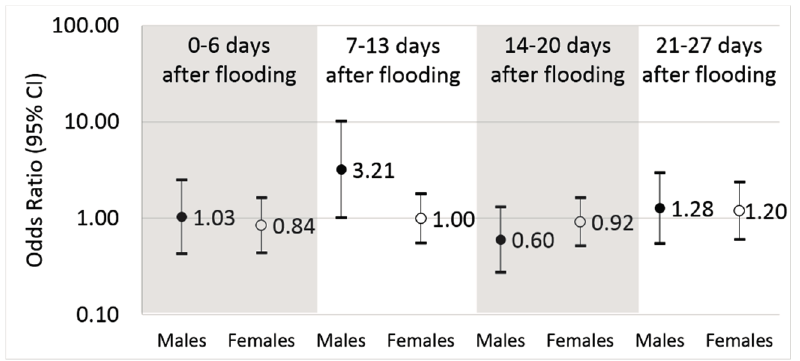
Figure 3. Association between flooding and health care visits for Clostridium difficile , by